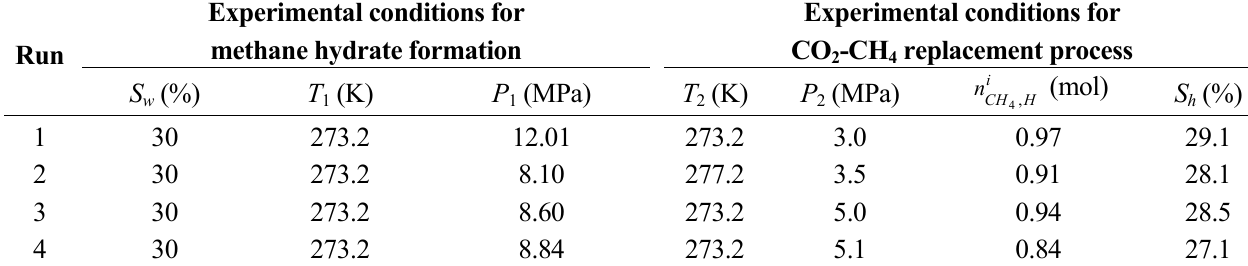
Table 1. Experimental conditions for methane hydrate formation and CO replacement in different